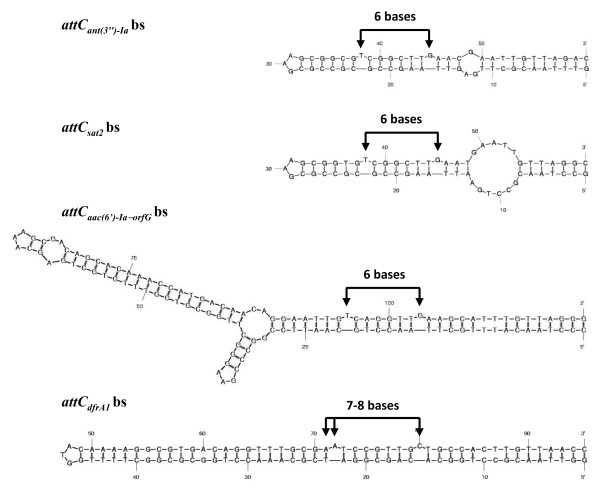
Secondary structure of the folded bottom strand of the attCant(3'')-Ia, attCsat2, attCaac(6')-Ia-orfG and attCdfrA1sites. The extrahelical bases are identified by arrows.